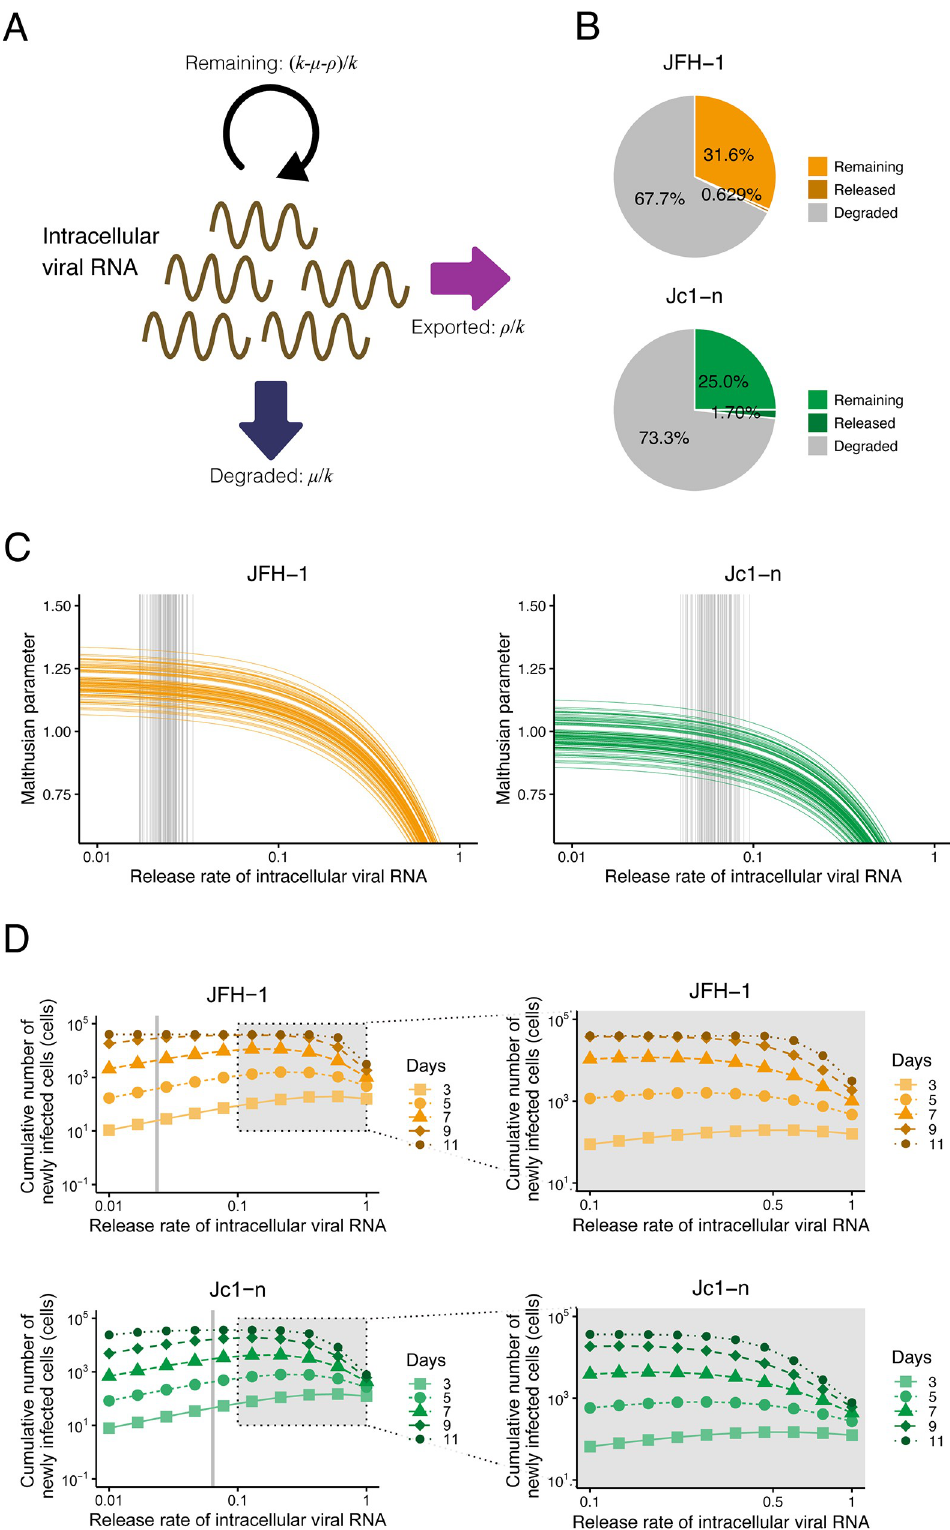
Fig 4. Different strategies adopted by JFH-1 and Jc1-n for viral proliferation. (A) Schematic representation of the fate of replicated intracellular viral RNA. Viral RNA is used either for driving RNA replication in cells or for